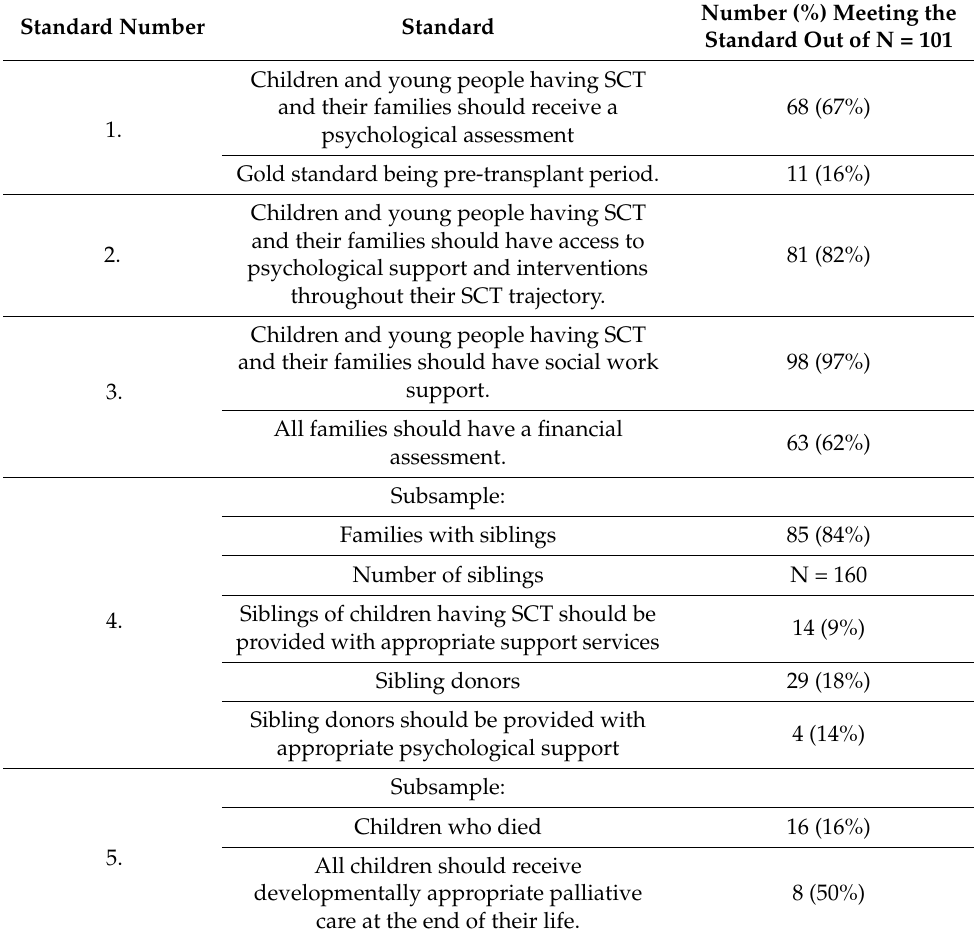
Table 2. Results of the Modified Psychosocial